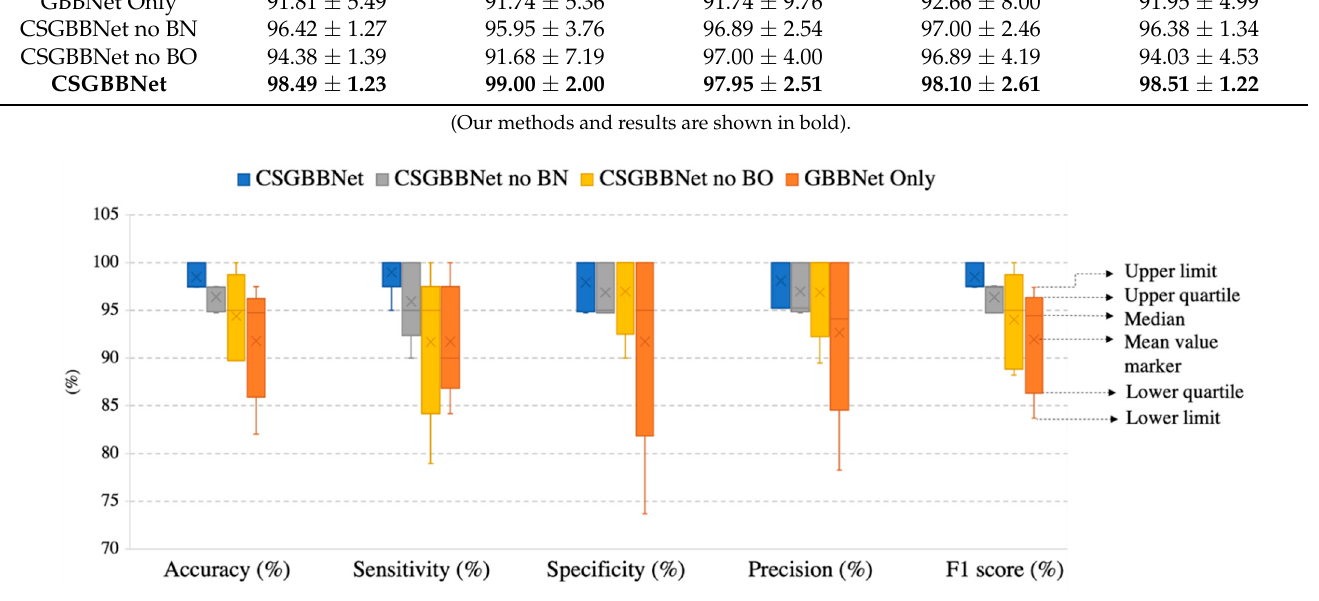
Table 7. Results of our ablation study.